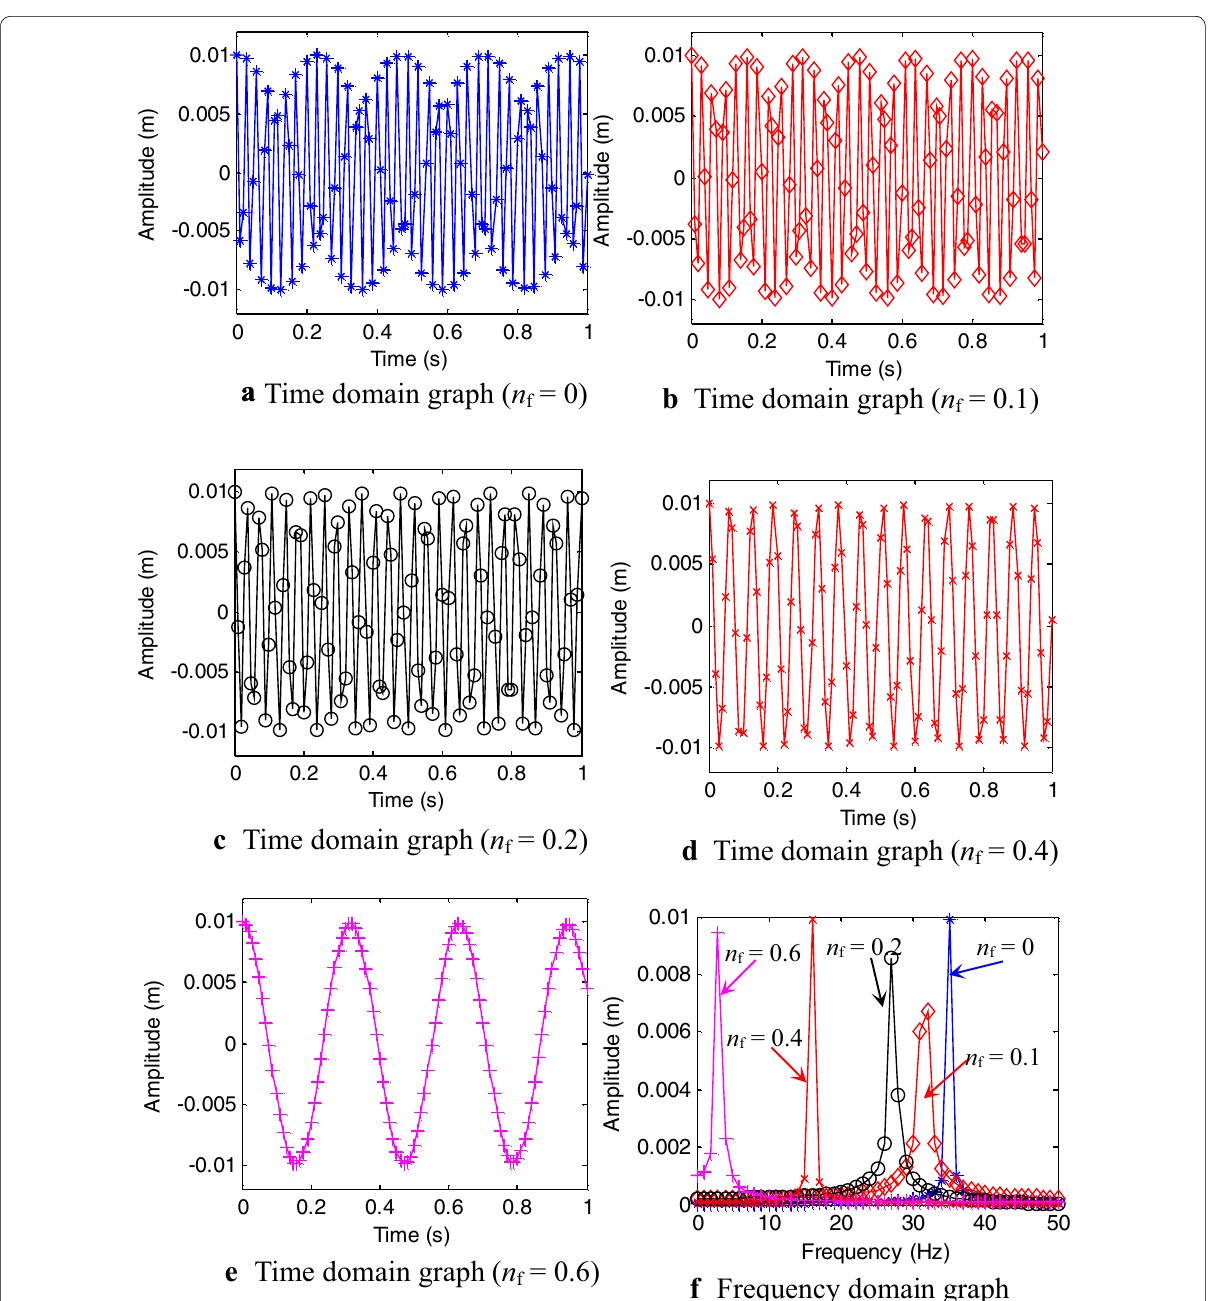
Figure 7 Motion of unit body. a Time domain graph (nf